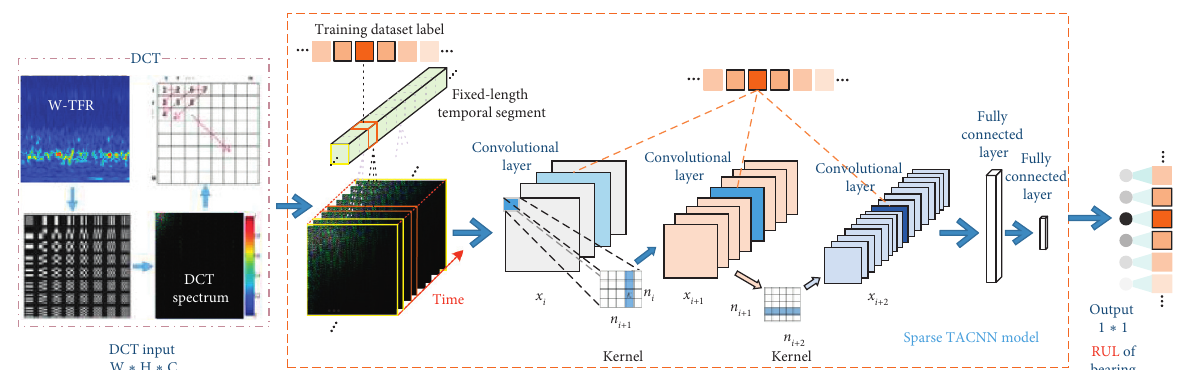
Figure 4: Architecture of sparse TACNN for RUL estimation. This architecture consists of three convolution layers and two fully connected layers. Detailed descriptions are given in the